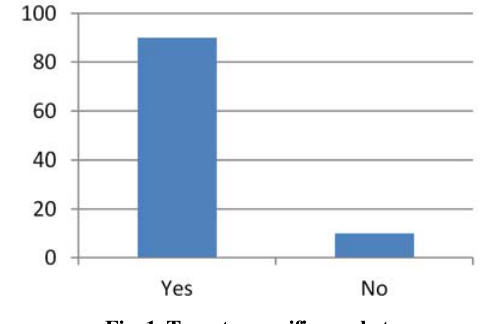
Fig. 1. Target a specific